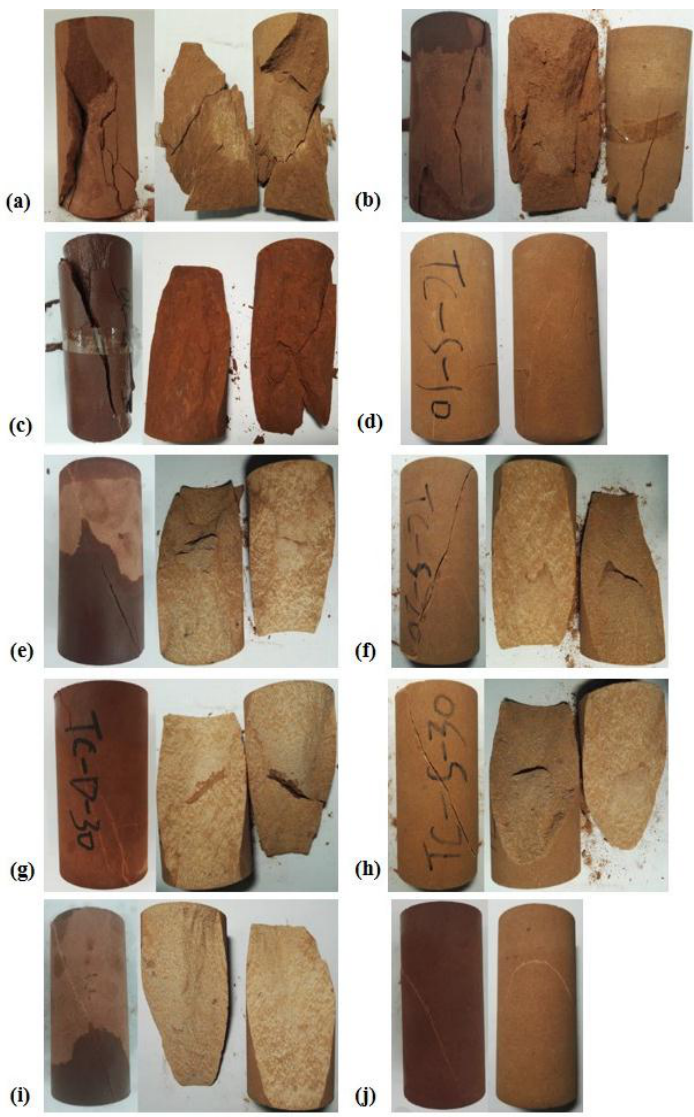
Figure 5. Failure modes of dry and saturated sandstones in conventional triaxial compression tests: